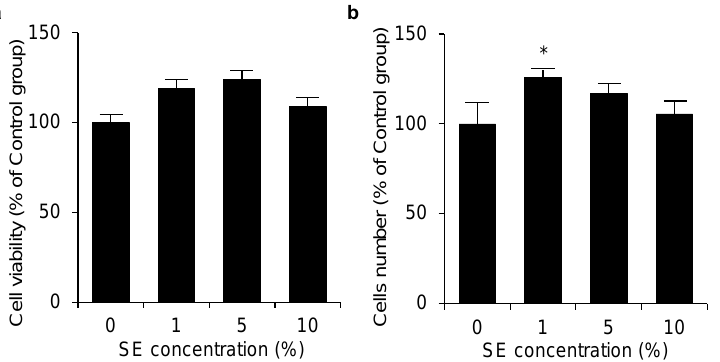
Figure 2. Cell viability and cell number of Shotokuseki extract on normal human epidermal keratinocytes (NHEKs). ( a ) Cells were treated with Shotokuseki extract for 24 h. Cell viability was determined by the MTT assay. Data are expressed as a percentage of control group and expressed as mean ± S.D. of six independent experiments. ( b ) Cells were treated with Shotokuseki extract for four days. Cell numbers were determined by the trypan blue exclusion test. Data are expressed as a percentage of control group and expressed as mean ± S.D. of three independent experiments. * p < 0.05 (compared with control group). Statistical significance was evaluated using the Dunnett’s multiple comparison